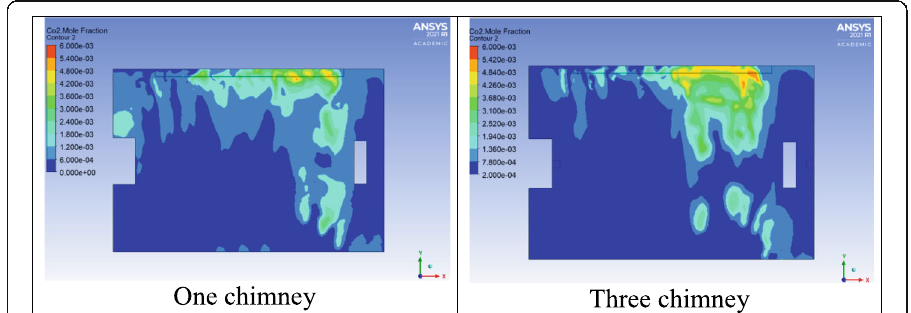
Fig. 16 Contours of CO 2 concentration in (ppm) for the number of chimneys at the breathing level zone 1.2 m, output from the ANSYS CFD model